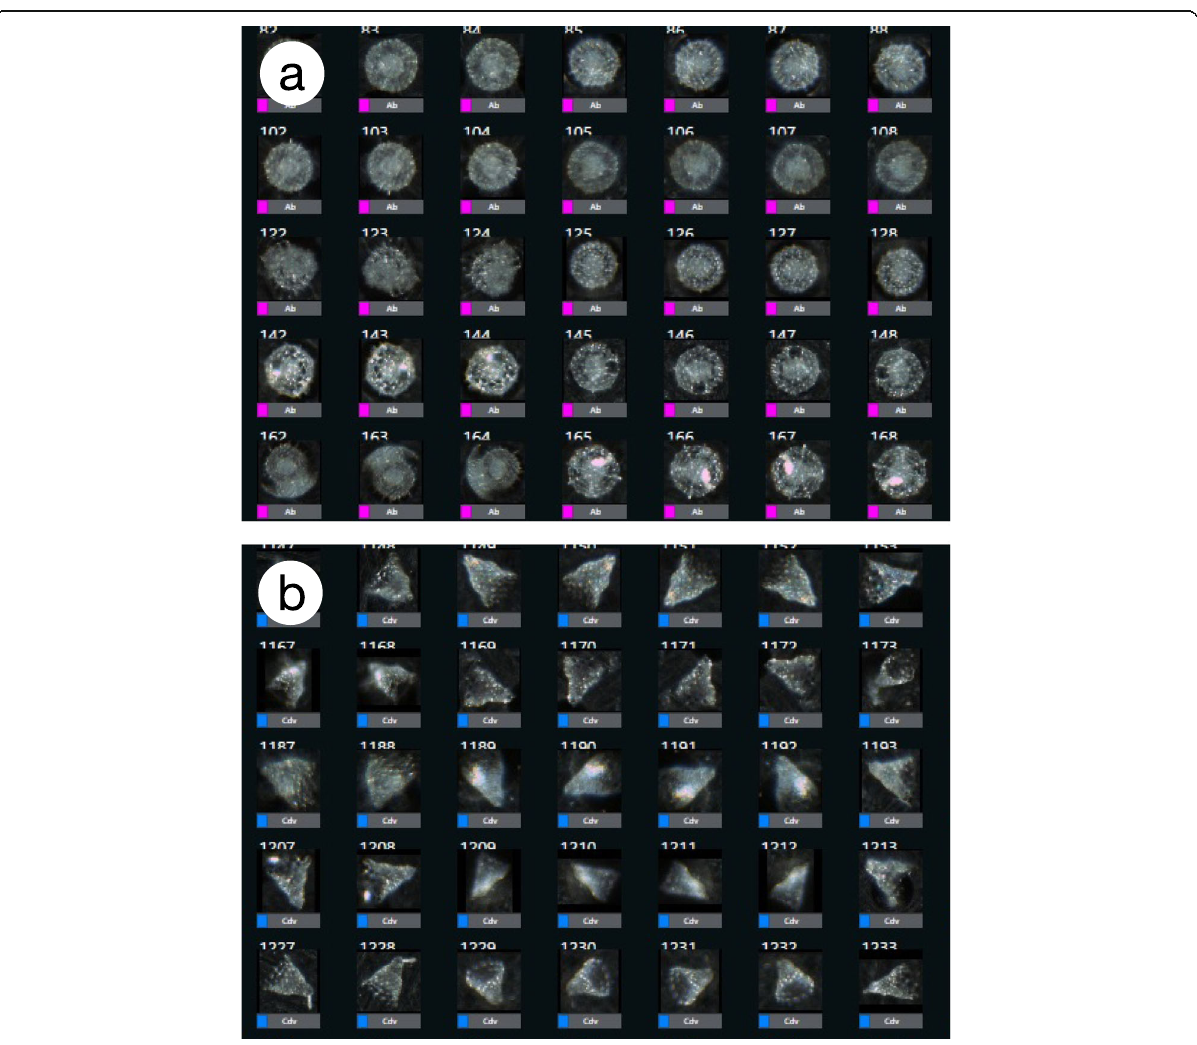
Fig. 3 Screen shots of subsets of training data for a Actinmma boreale and b Cycladophora davisiana used in model